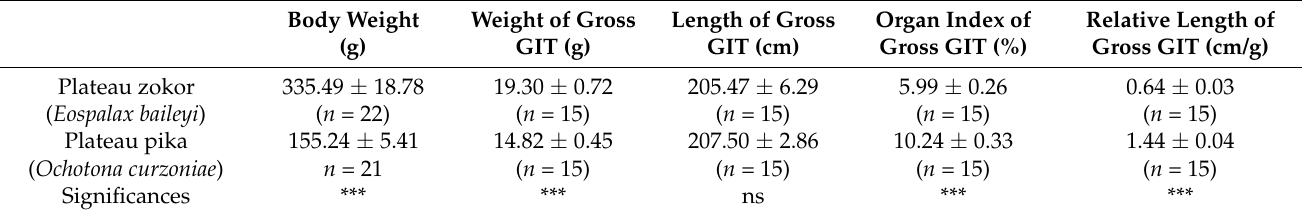
Table 1. Differences in gross GIT between the plateau zokor and plateau pika.